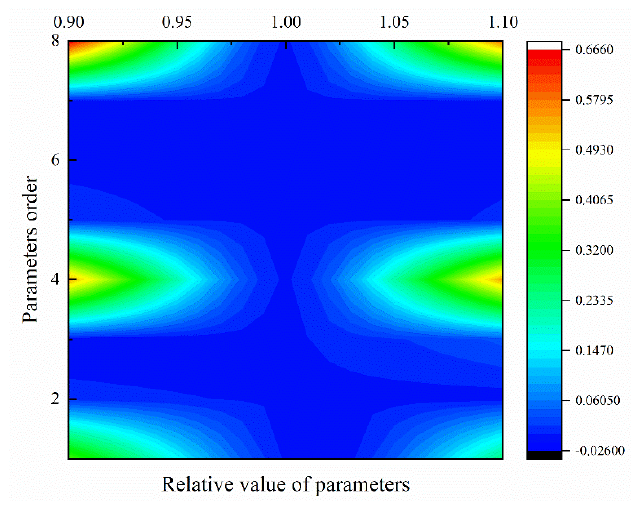
Figure 9. Sensitivity of eight DAEM parameters for 50 µm PS pyrolysis. This figure shows 50 µm PS particle case, and the sensitivity of other particles shows the same weight distribution.